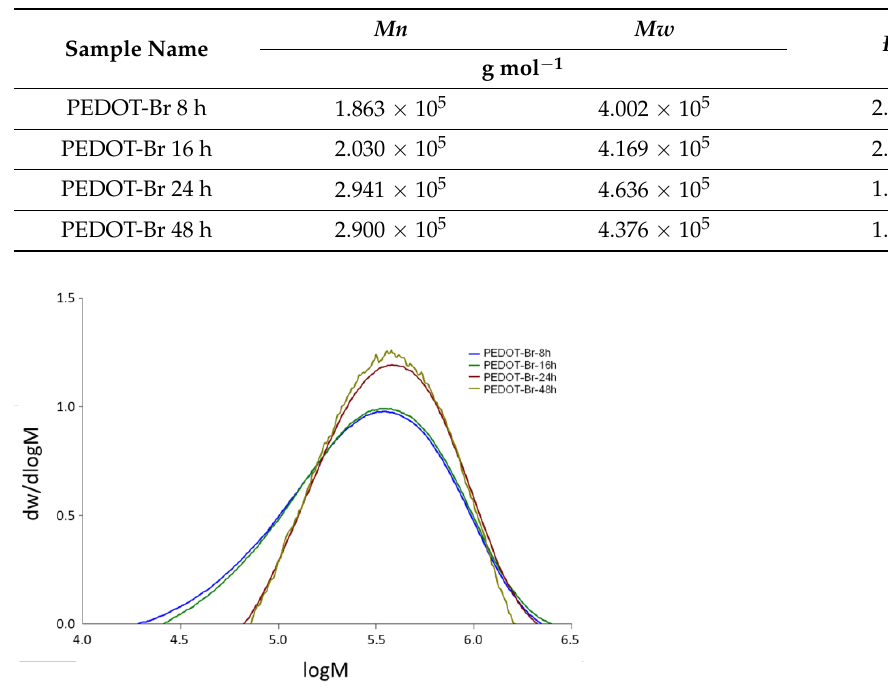
Figure 5. GPC analysis of PEDOT-Br macroinitiators with different synthesis durations.